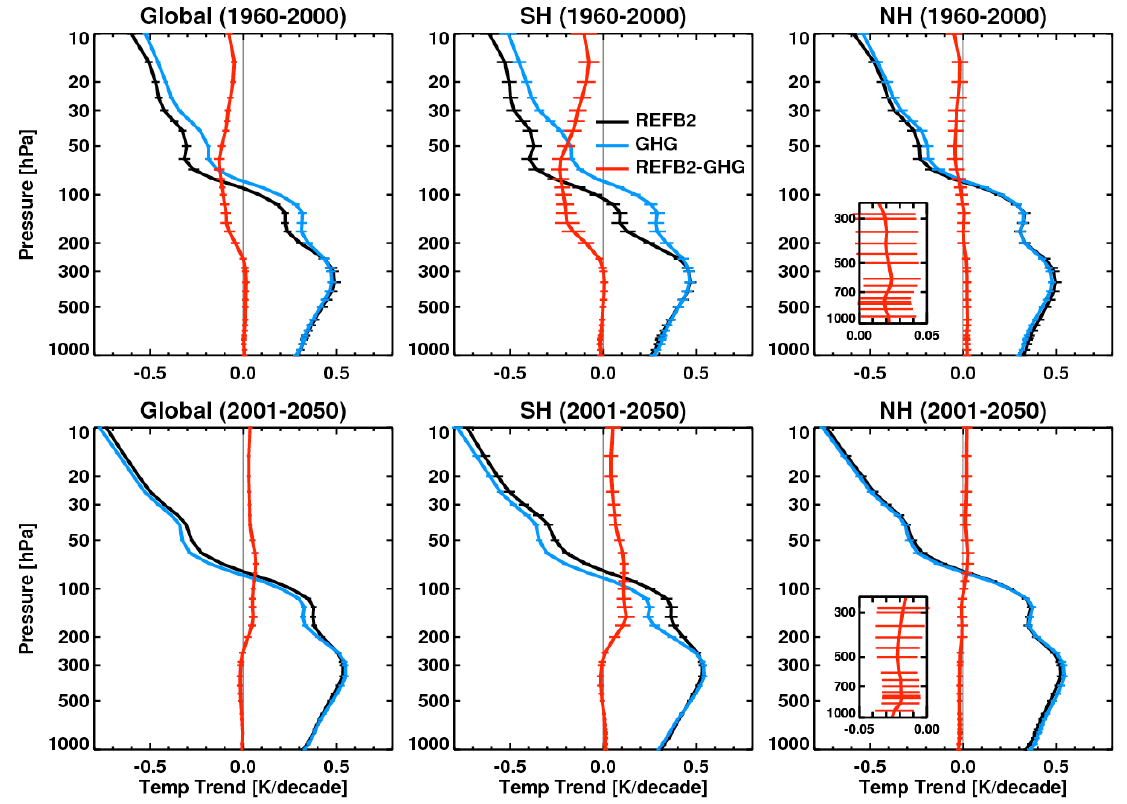
Fig. 2. Annual mean temperature trends for 1960-2000 (top) and 2001-2050 (bottom): global average (left), Southern Hemisphere (middle) and Northern Hemisphere (right) for REF-B2 (black), GHG (blue) and REF-B2 minus GHG (red). Error bars denote the 95% confidence levels of the trends. The insets in the two right panels show blow-ups of the REF-B2-minus-GHG trends in the troposphere.